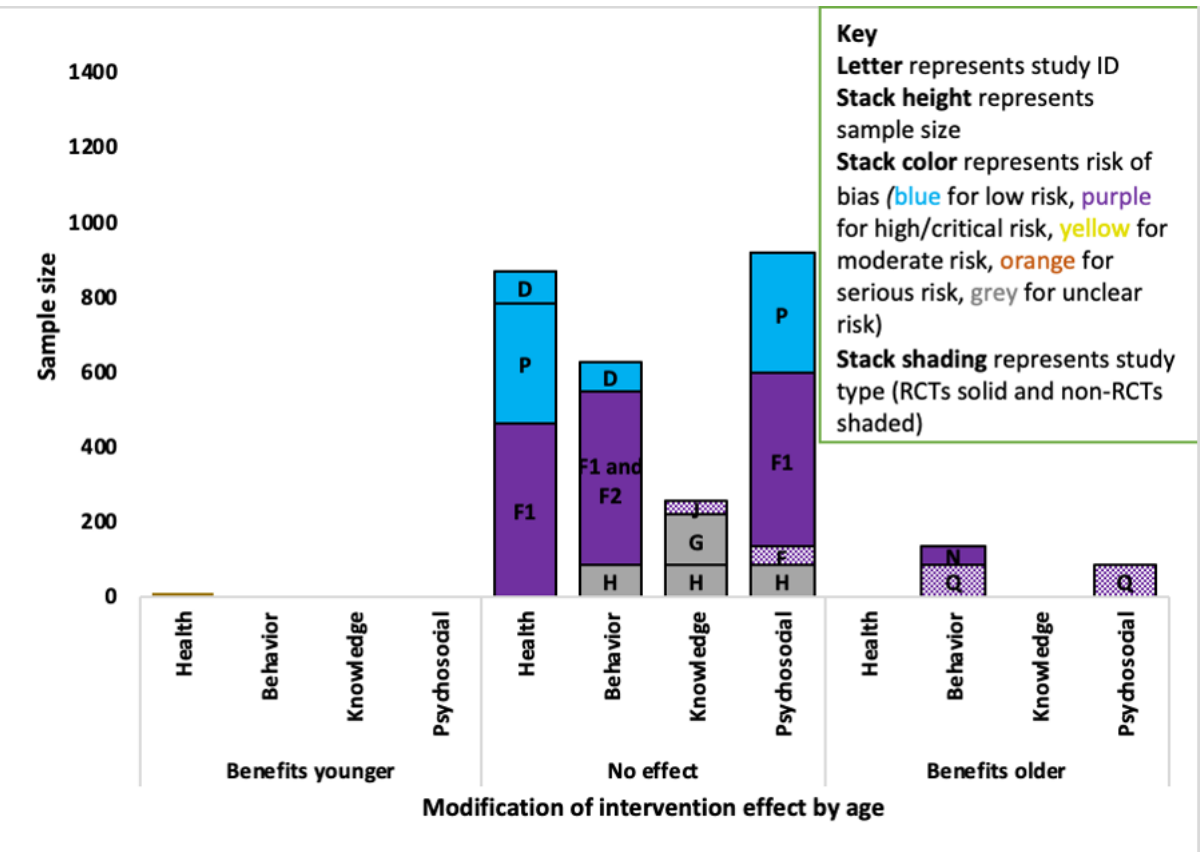
Figure 5. Adapted Harvest plot with evidence for increasing age-modifying intervention effects across outcomes in diabetes studies. RCT: randomized controlled trial.